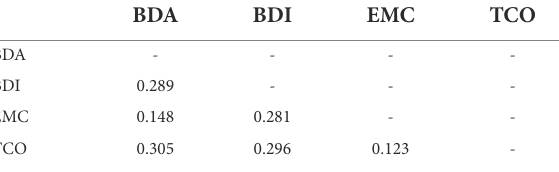
TABLE 4 Discriminant validity